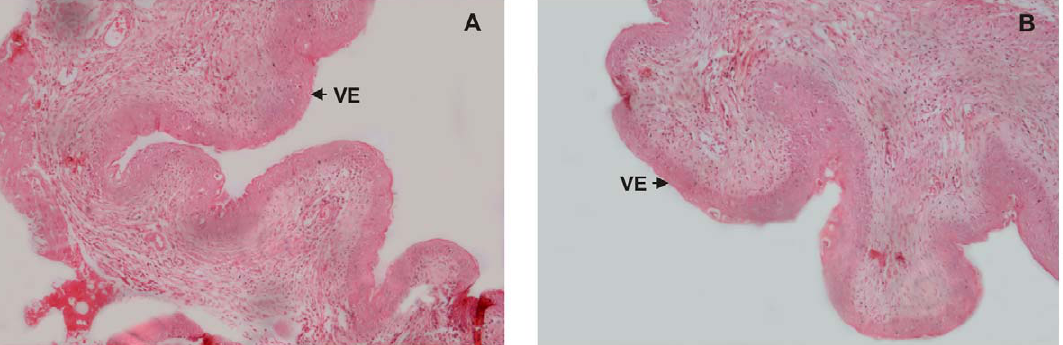
Figure 5. Histopathological examination of vaginal tissues. Hematoxylin and eosin stained sections and light micrographs of mouse vagina after 10 days of daily treatment with 10 8 cfu of spermagglutinating strain of S. aureus or PBS. Normal vaginal epithelium (VE) is observed in the control and the test samples. No histopathological changes were observed in the vaginal sections (ulceration, edema, or leukocyte infiltration) of the test (A) or in the representative control receiving PBS (B). Original magnification 100X.